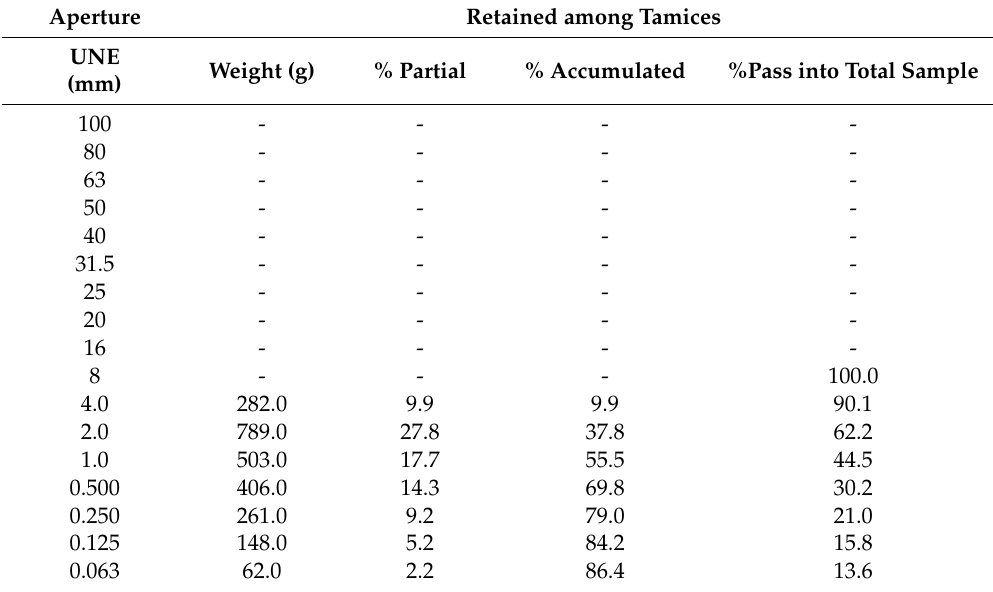
Table 1. Aggregate granulometric